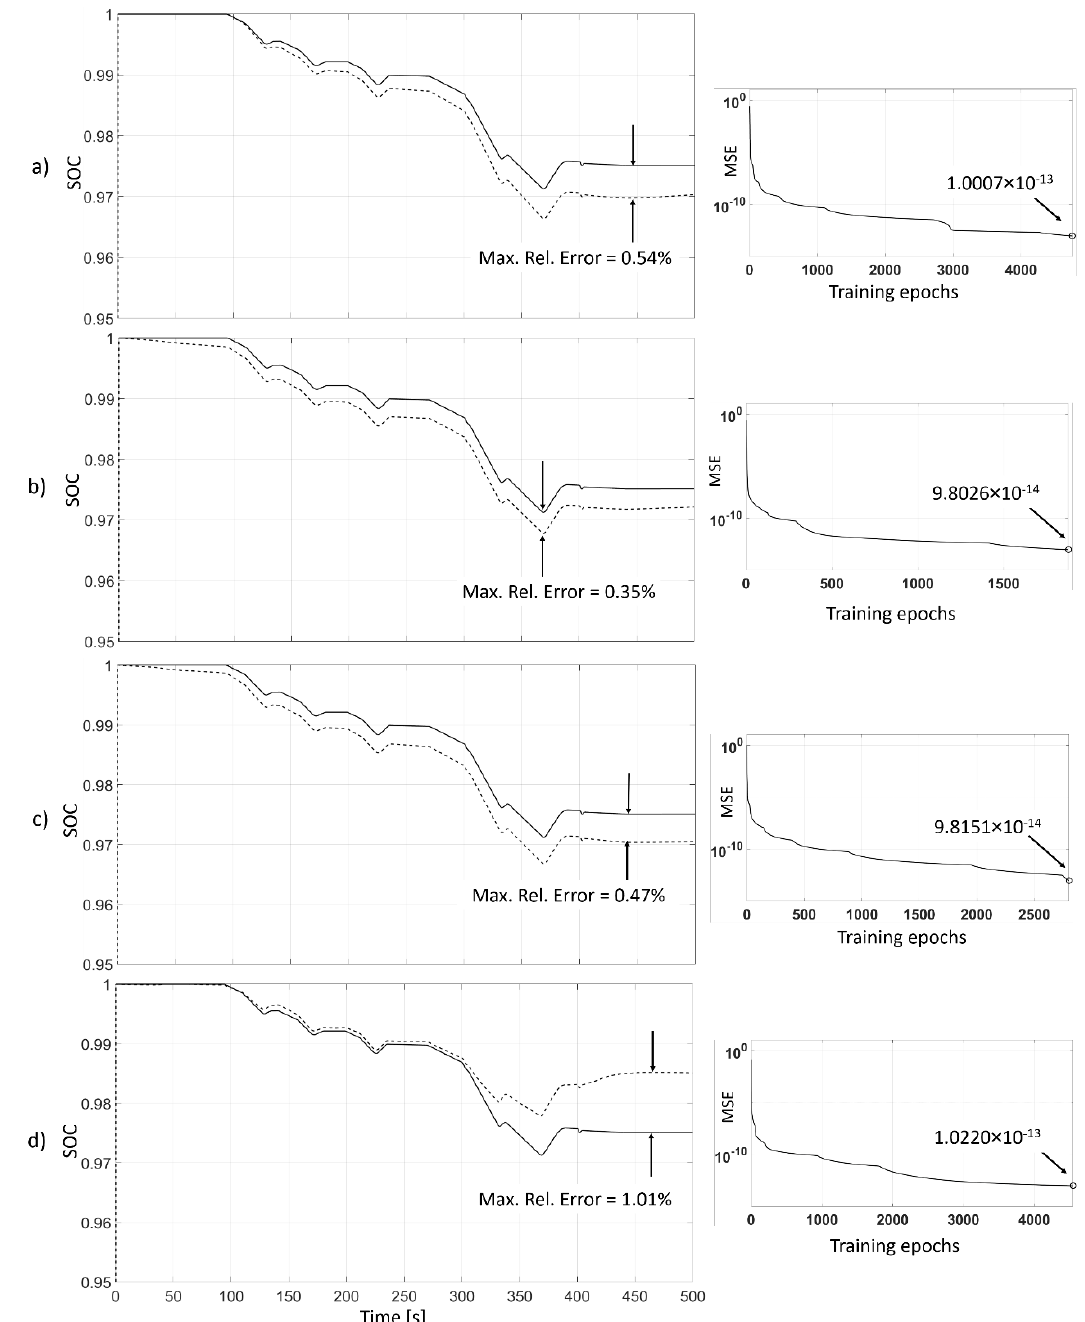
Figure 7. Performance of the closed loop NARX ANNs with 5 ( a ), 8 ( b ), 15 ( c ) and 20 ( d ) neurons in the hidden layer. The SOC estimation and Mean Square Error trend during the training process of each network are reported in the left-hand and right-hand column, respectively.